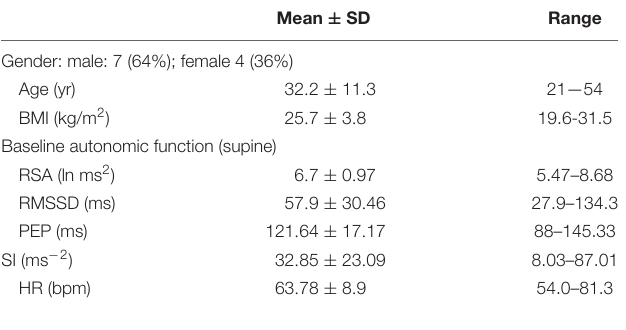
TABLE 1 | Participant characteristics ( n = 11). Mean ± SD